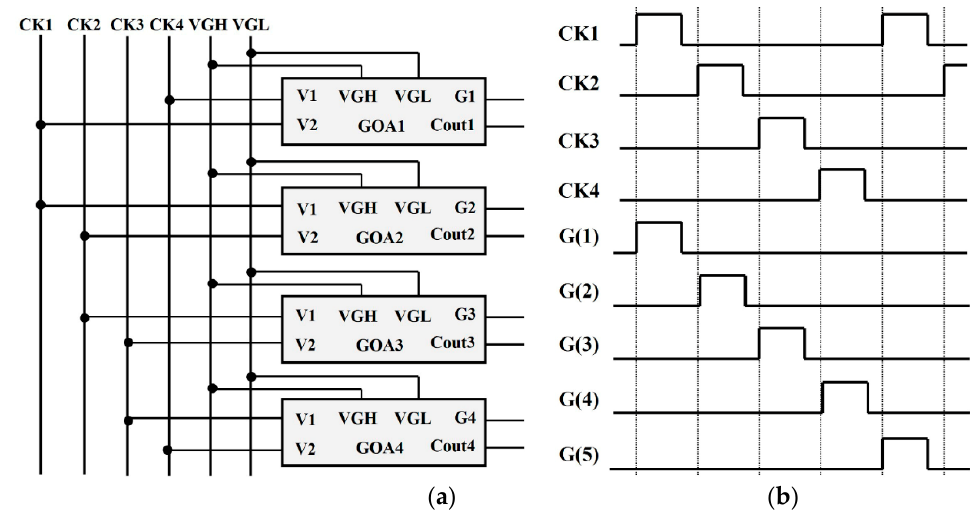
Figure 3. ( a ) Block diagram of a basic loop unit in SR circuit; ( b ) The diagram of clock signals.